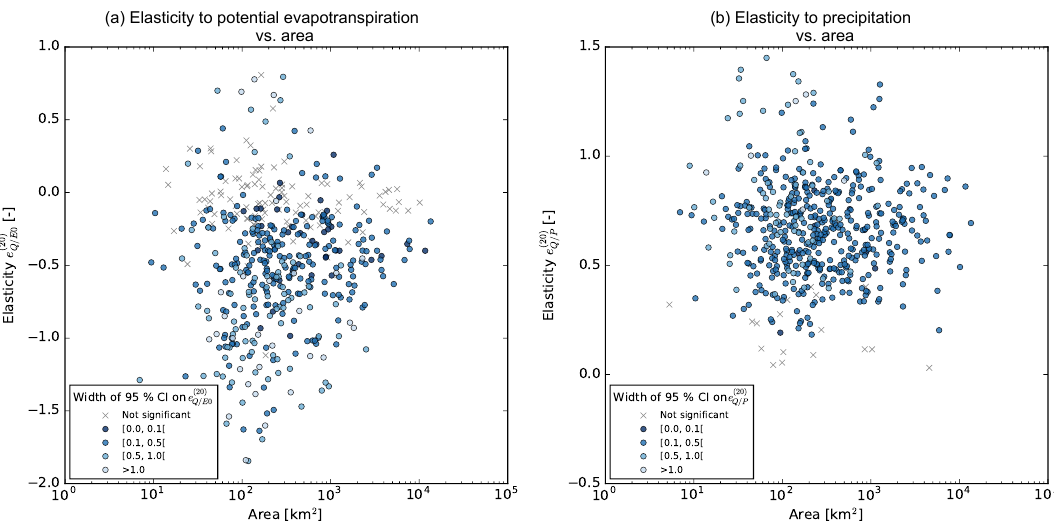
Figure 10. Elasticity values vs. catchment area: (a) streamflow elasticity to potential evaporation and (b) streamflow elasticity to precipitation. Elasticity values were obtained by the GLS2 regression method with sub-periods of 10 years. The points are colored according to the width of the 95% bootstrap confidence intervals on the GLS2 elasticity